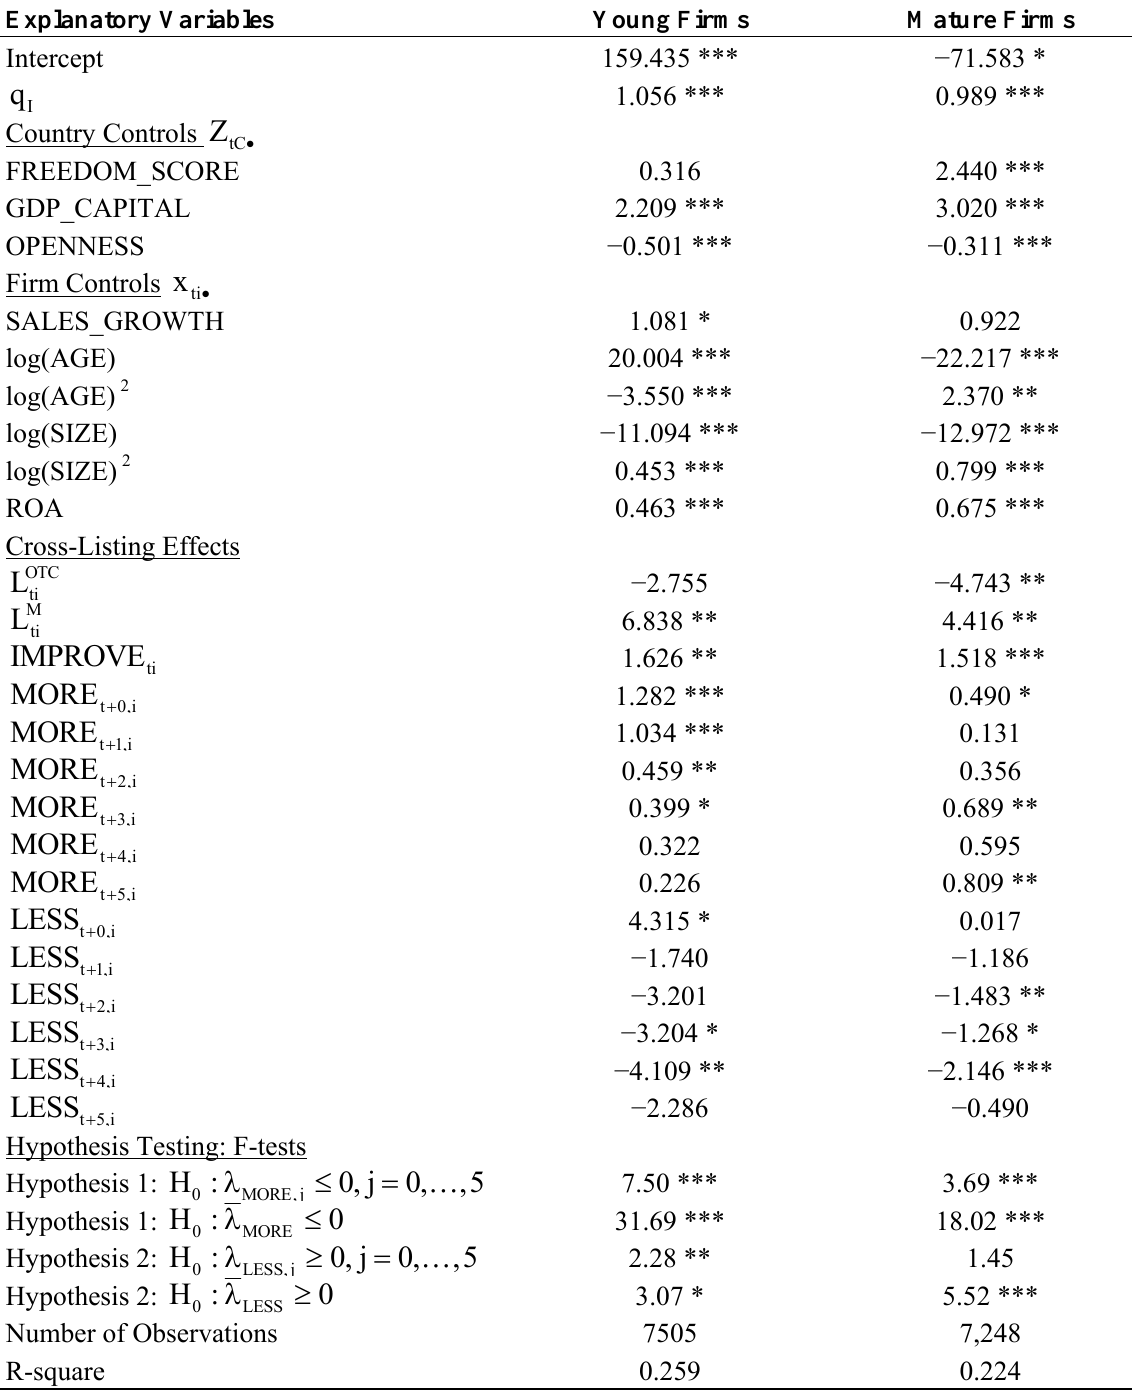
Table 8. Conditional Regressions with Cross Listings by Maturity of Firms Dependent Variable: Firm’s Tobin’s